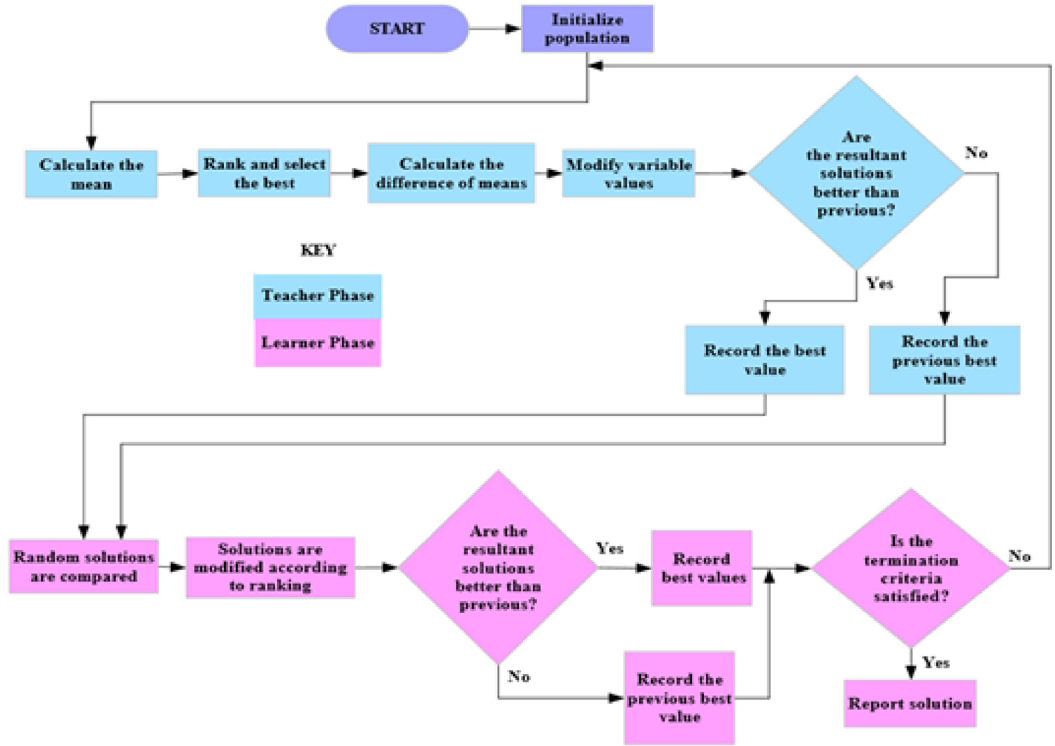
Fig. 4. TLBO fl ow chart